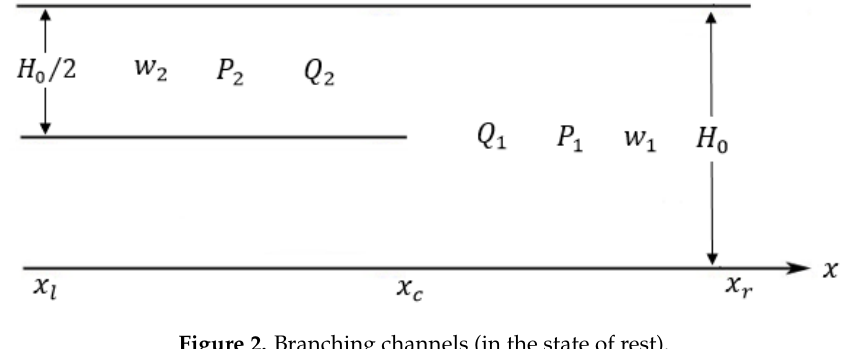
Figure 2. Branching channels (in the state of